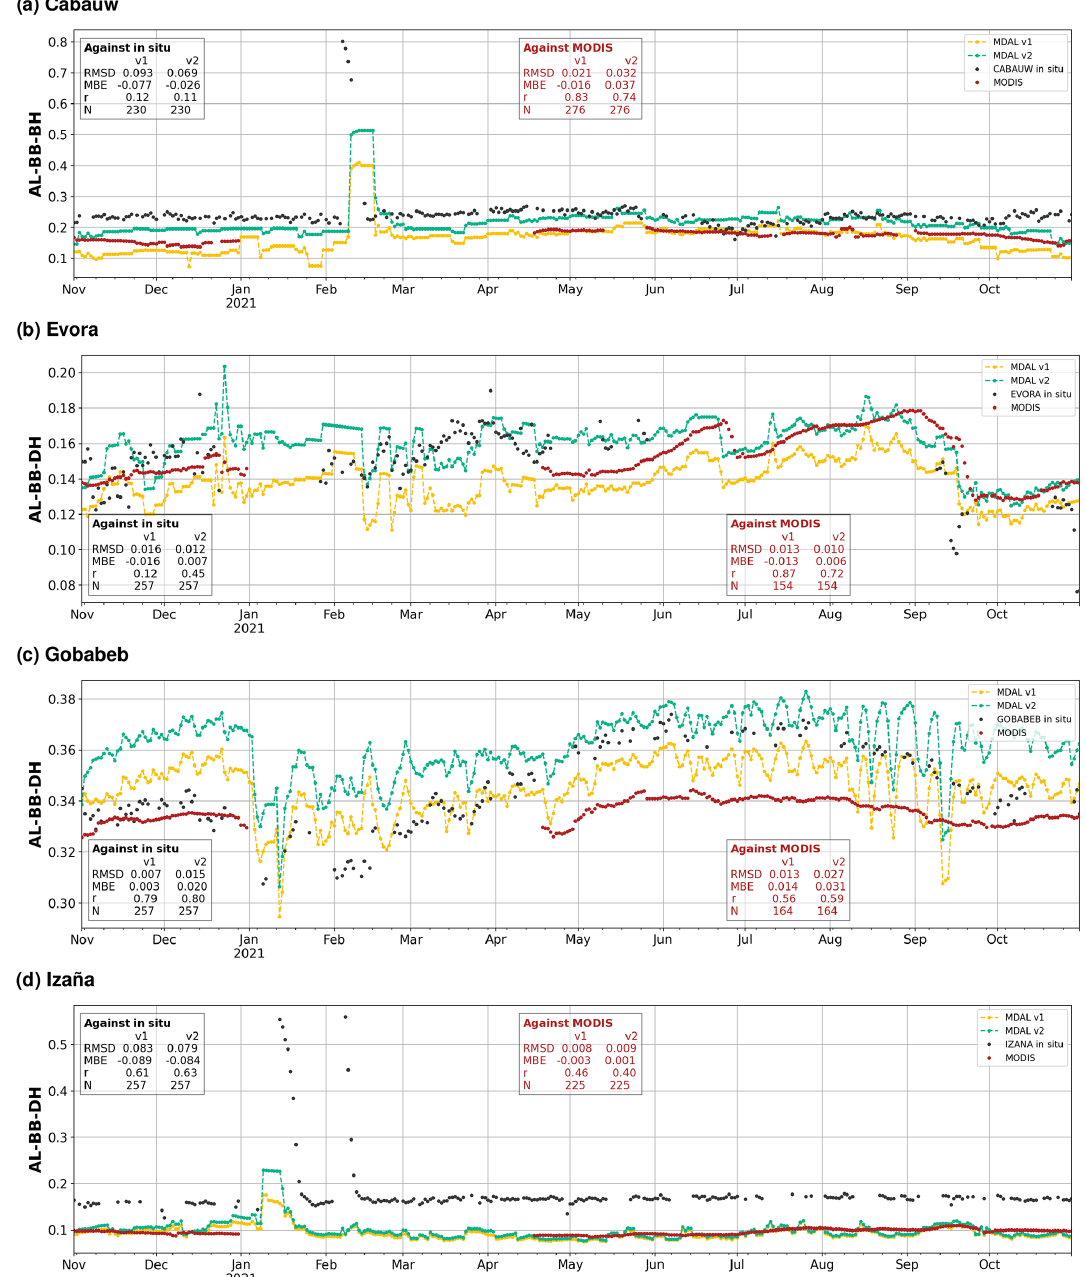
Figure 12. MDAL v1 and v2 compared to albedo estimates at in situ observation stations (a) Cabauw (white-sky albedo), (b) Evora (in situ: blue-sky albedo; satellites: black-sky albedo), (c) Gobabeb (black-sky albedo) and (d) Izaña (black-sky